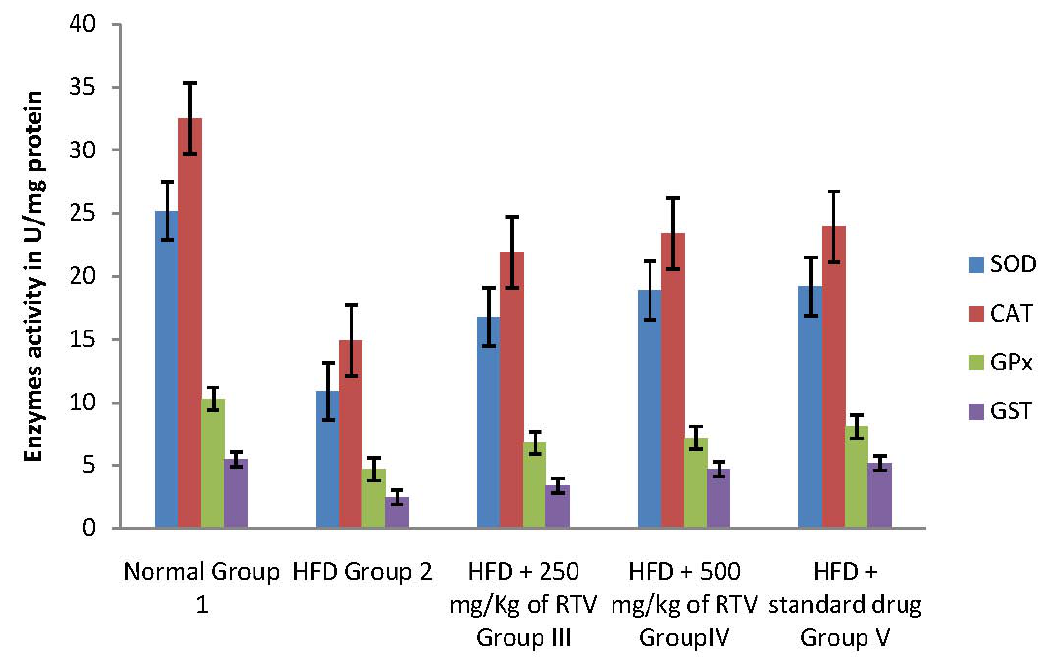
Figure 2. Effects of methanolic extract of rhizomes of T. violacea treatment on antioxidants defense viz., Superoxide dismutase (SOD), Catalase (CAT), glutathione peroxidase (GPx), and glutathione-S-transferase (GST) in high fat diet induced oxidative stress in rats aorta homogenate.